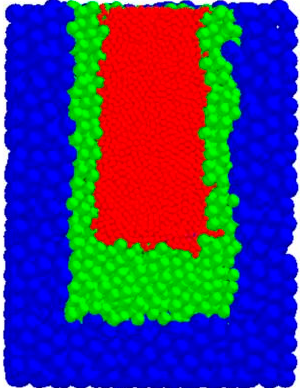
Figure 1. Three-stage variable particle diameter within the particle system.(The red zone has a particle radius of 0.8 mm, the green zone has a particle radius of 1.6mm, and the blue zone has a particle radius of 2.4 mm).